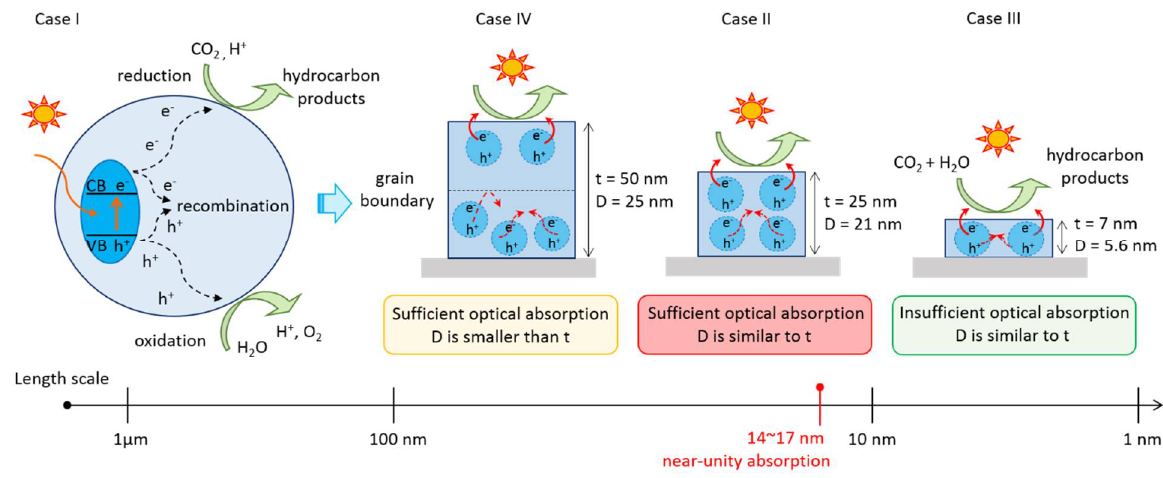
Figure 10. Schematic illustration of the proposed mechanism of ultra-thin film MoS 2 photocatalysts for visible light-driven CO 2 reduction.